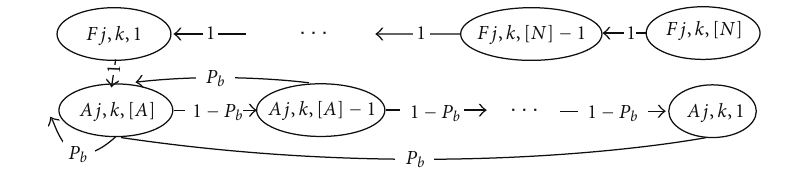
Figure 11: Frozen and AIFS blocs ( j , k ); 0 ≤ j ≤ m , 1 ≤ k ≤ w j